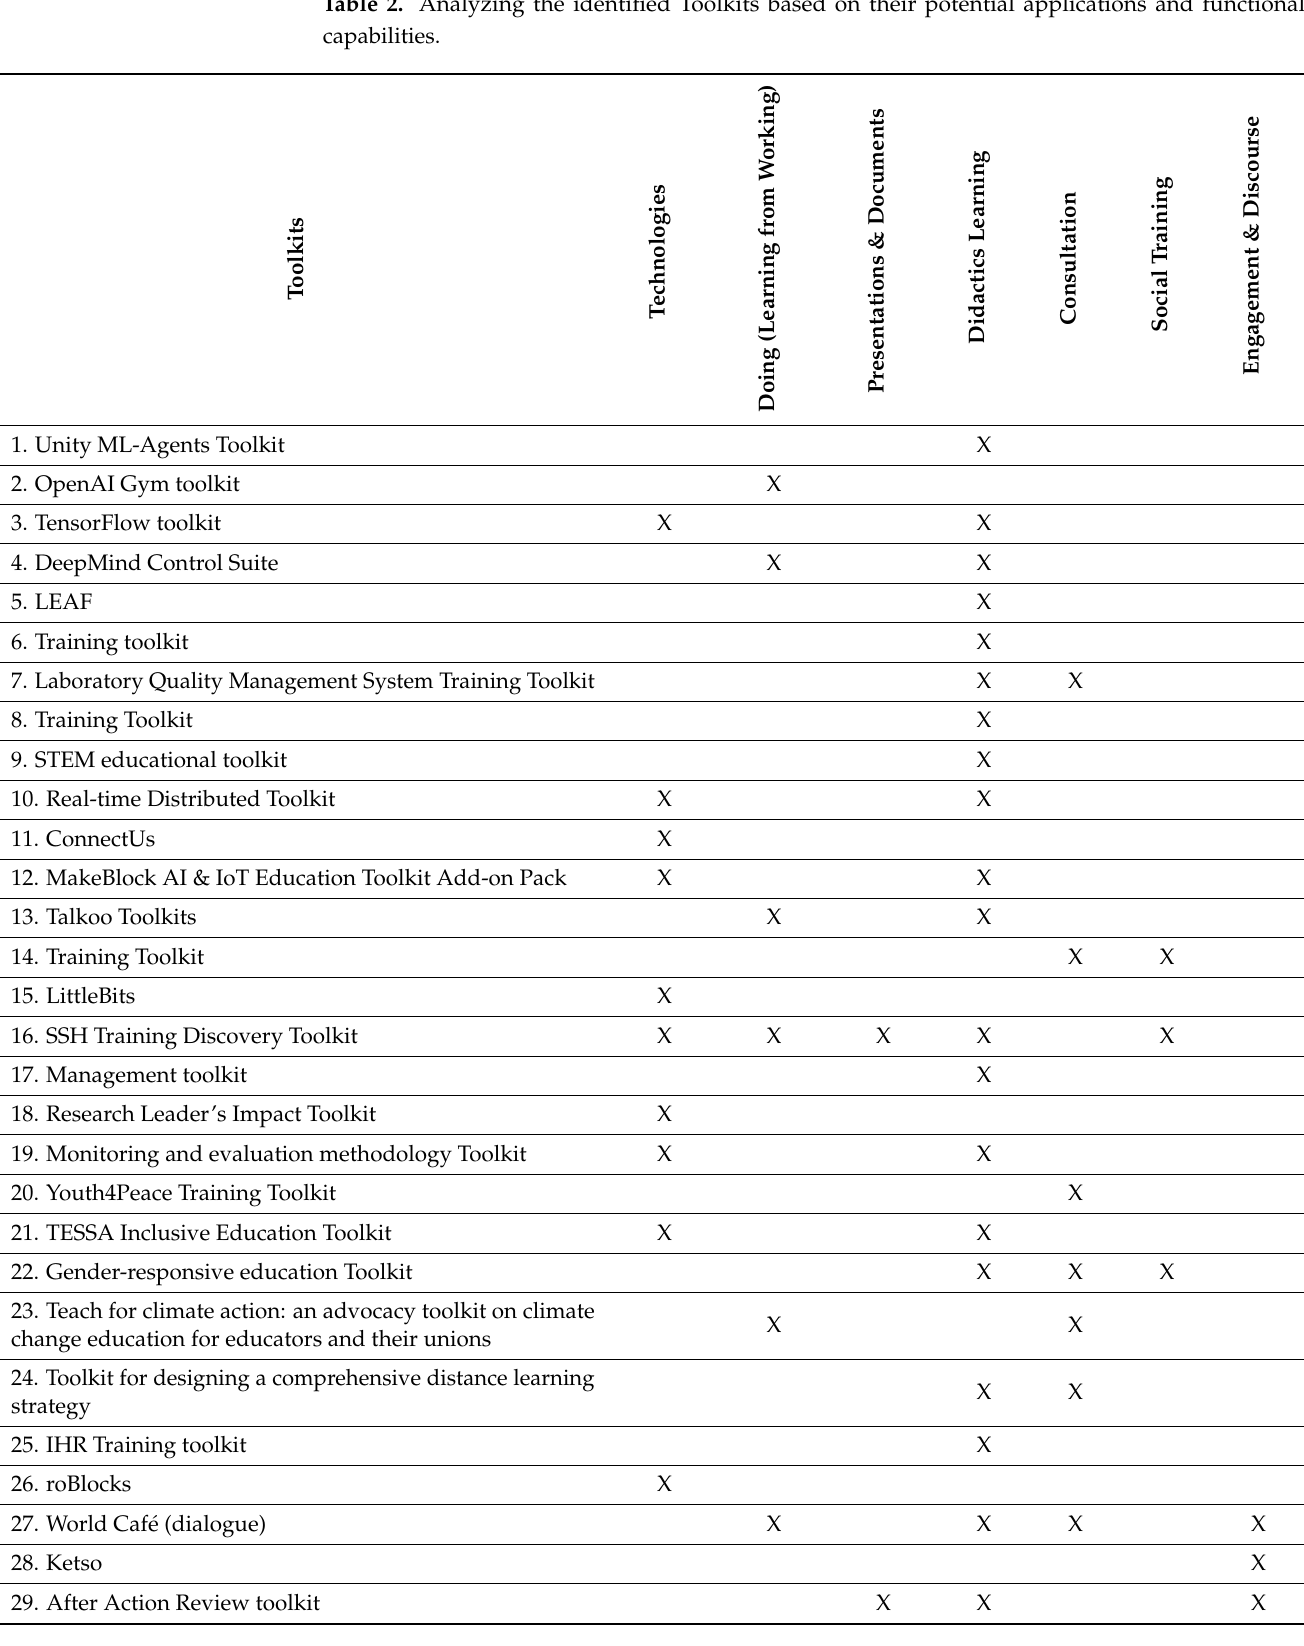
Table 2. Analyzing the identified Toolkits based on their potential applications and functional